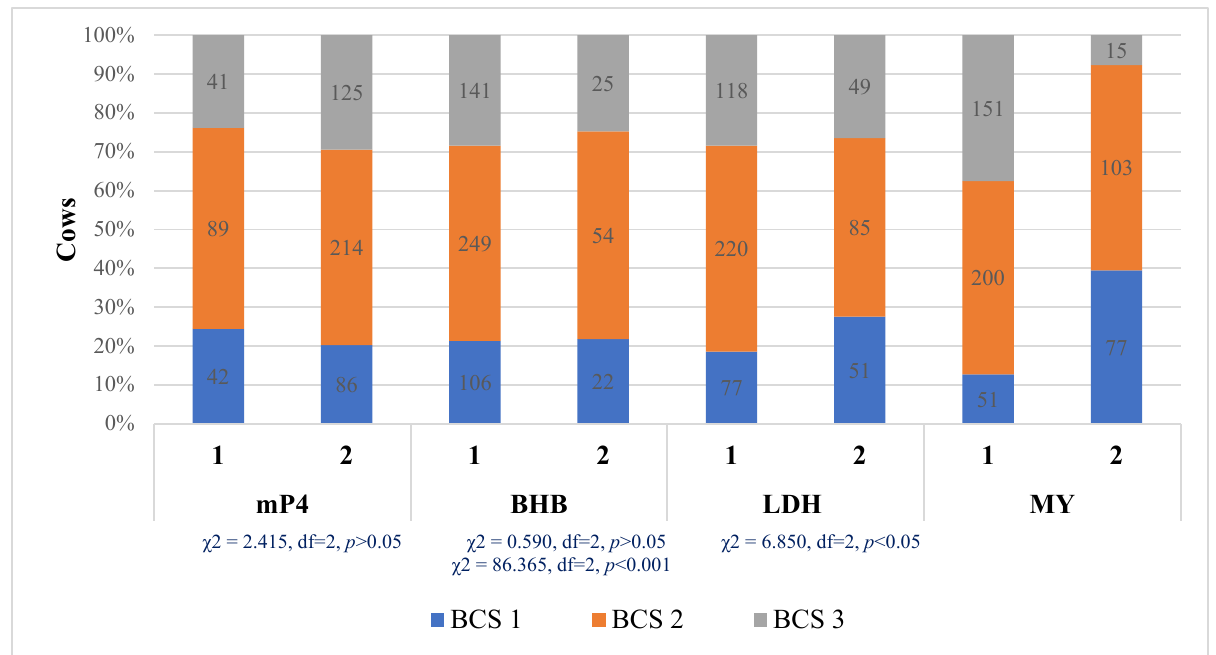
Figure 2. Relationship between the body condition scores of cows with other biomarkers from the Herd Navigator TM system. mP4 1—milk progesterone ≤ 15.5 ng/mL; mP4 2—milk progesterone > 15.5 ng/mL; BHB 1— β -hydroxybutyrate in milk ≤ 0.06 mmol/L; BHB 2— β hydroxybutyrate in milk > 0.06 mmol/L; LDH 1—milk lactate dehydrogenase ≤ 27 µ mol/min; LDH 2—milk lactate dehydrogenase > 27 µ mol/min; MY 1—milk yield ≤ 31 kg/day; MY 2—milk yield > 31 kg/day; BCS1 = 2.5–3.0; BCS2 ≥ 3.0–3.5; BCS3 ≥ 3.5–4.0.